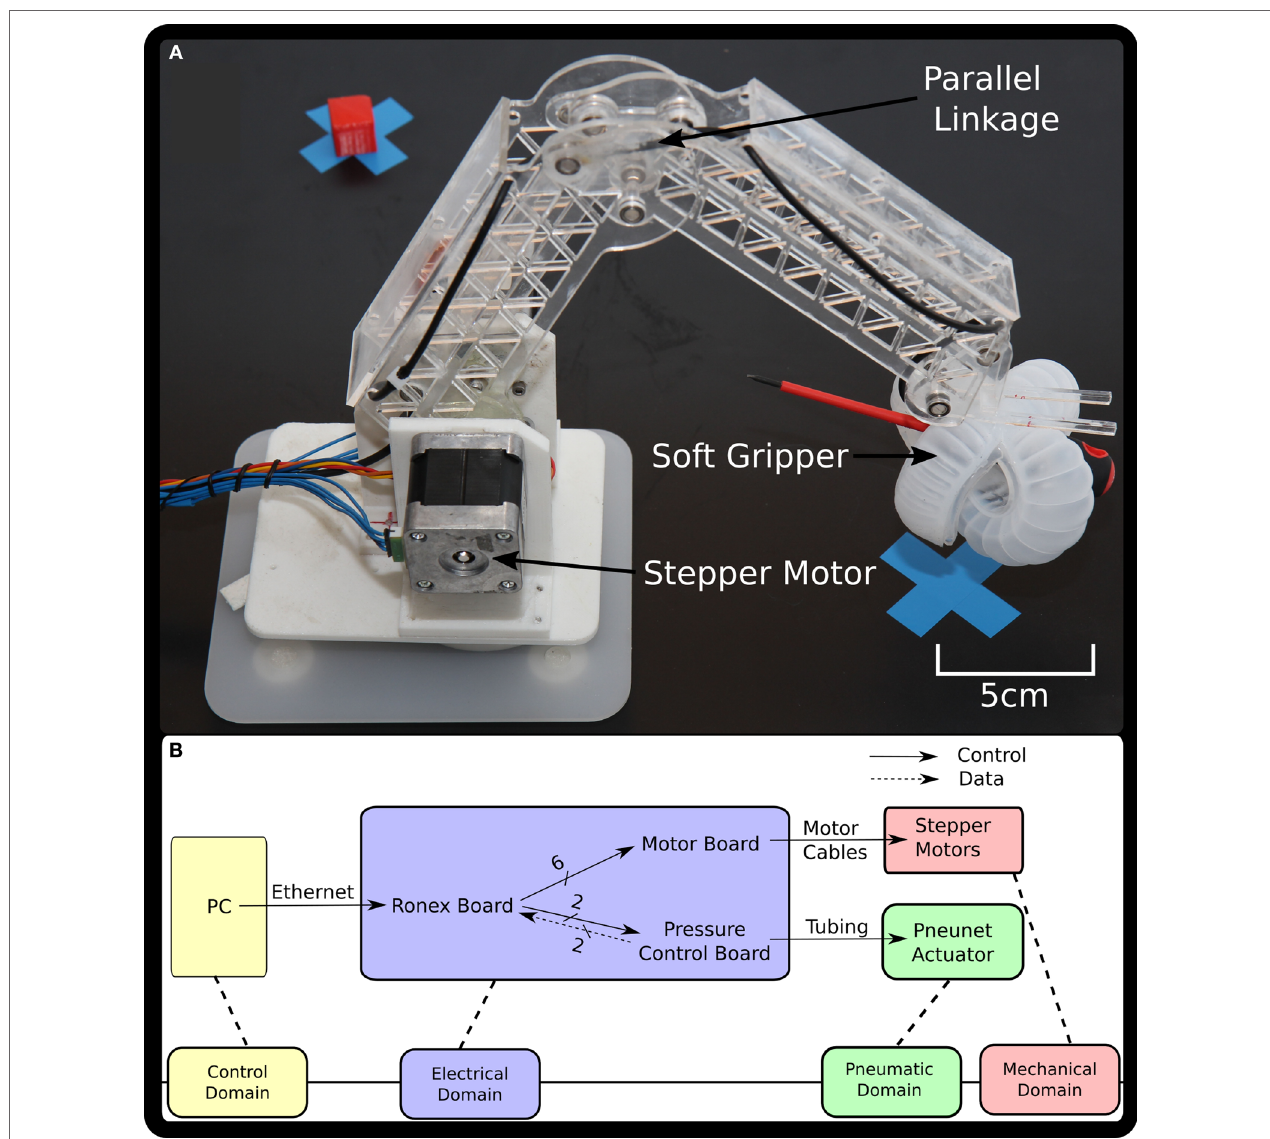
FigUre 1 | An overview of the open source system. (a) A picture of the soft–hard hybrid arm. (B) A block diagram of the